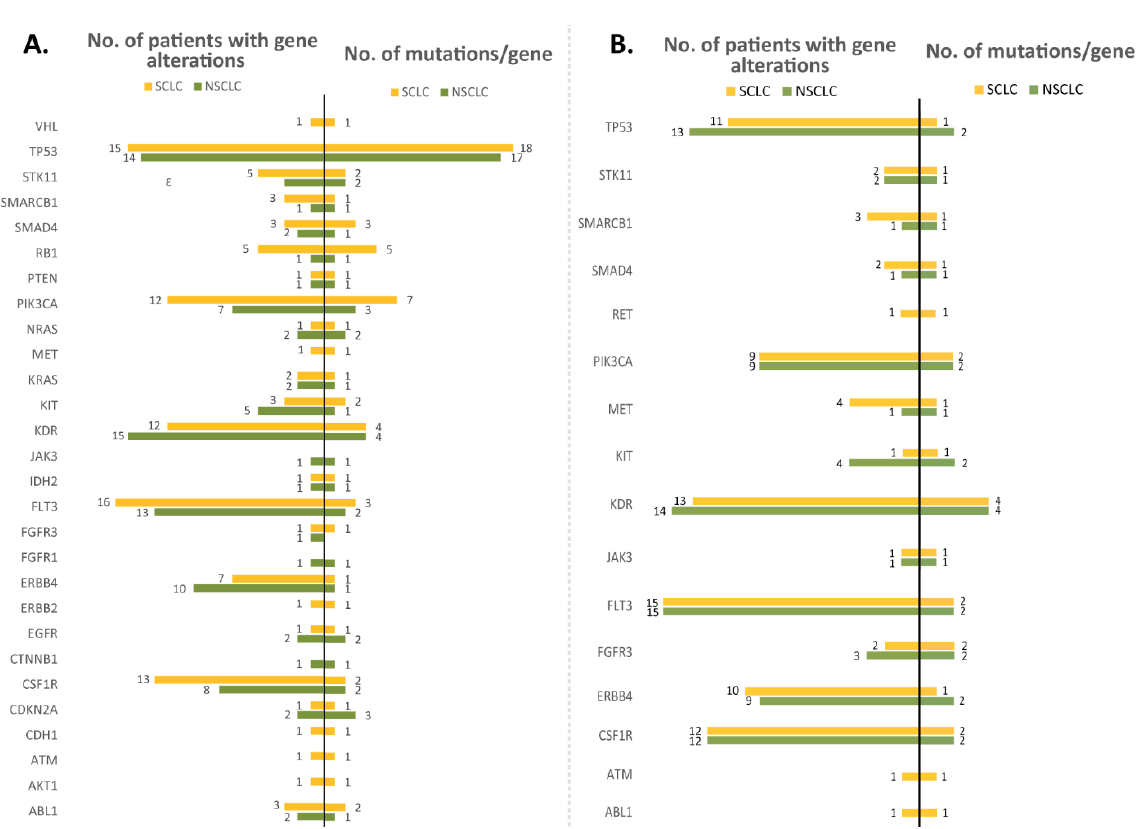
Figure 7. Bar graph representing the number of different mutations identified in each gene (right) and the number of patients in which at least one variant was detected for each gene (left) in NSCLC samples (green) and SCLC samples (yellow) in tumor tissue samples ( A ) and whole blood samples ( B ).